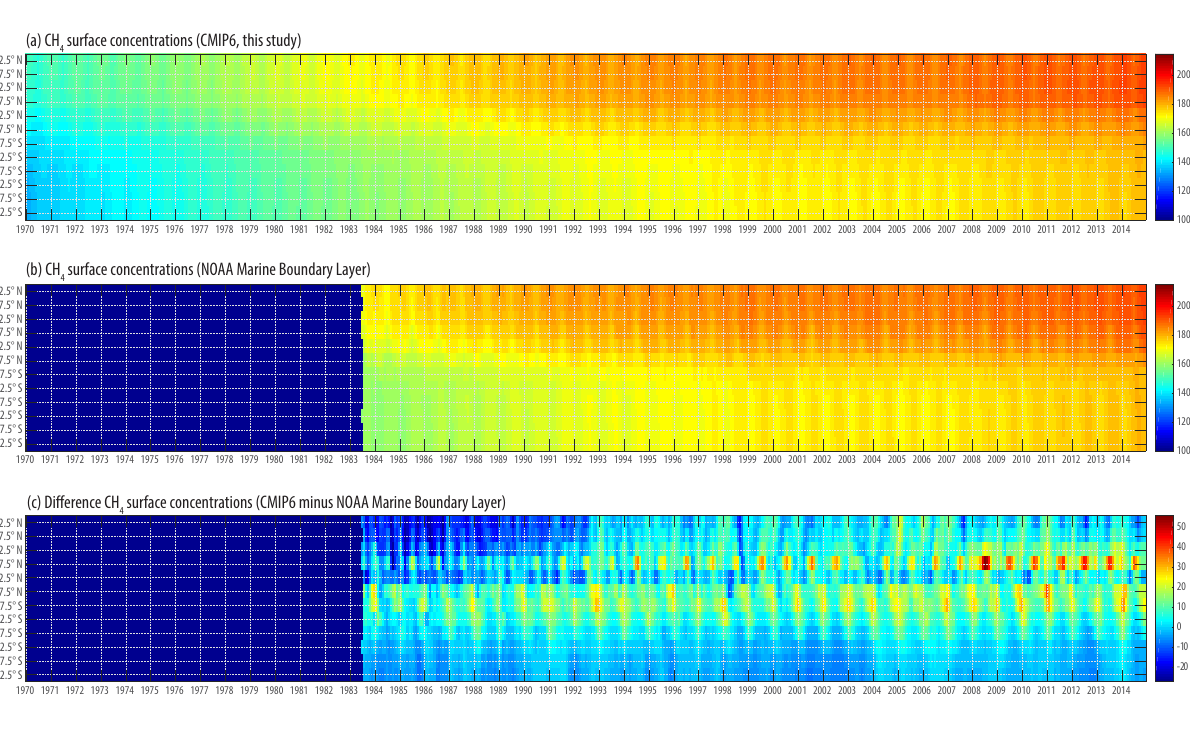
Figure 18. Comparison of the surface CH 4 monthly mean concentrations between CMIP6 (a) and the NOAA Marine Boundary Layer product (b) , and the difference between them (c) . Since around 1992, there are seasonal differences in the mid-northern latitudes with the CMIP6 data being up to 50ppb higher than the NOAA MBL product. Similarly, higher concentrations are apparent in the areas of tropical southern and lower latitude southern areas, presumably due to differences of data over land areas.